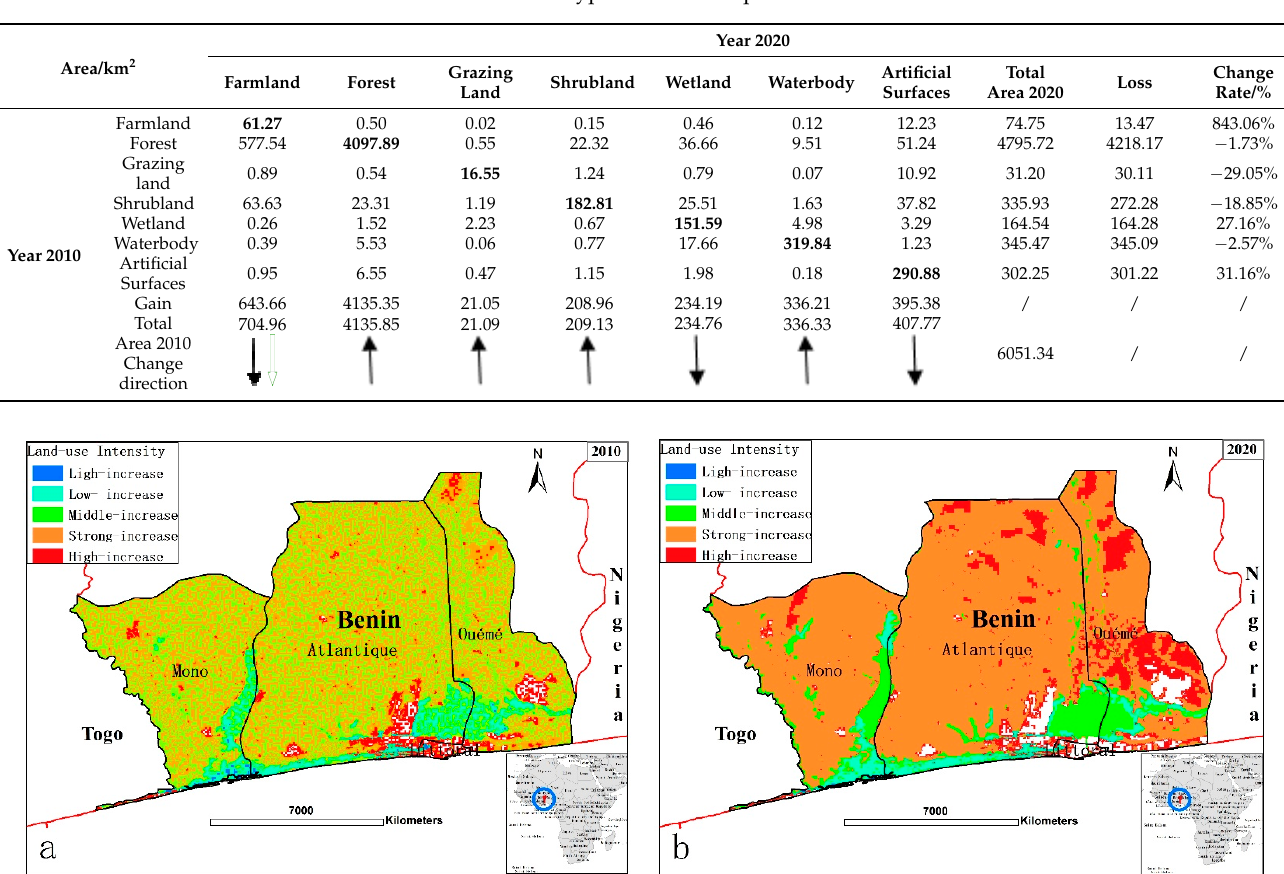
Figure 5. Spatial distribution of land-use intensity from 2010 to 2020 in Benin tropical coastal region. ( a ) Spatial patterns in the year 2010, ( b ) Spatial patterns in the year 2020.